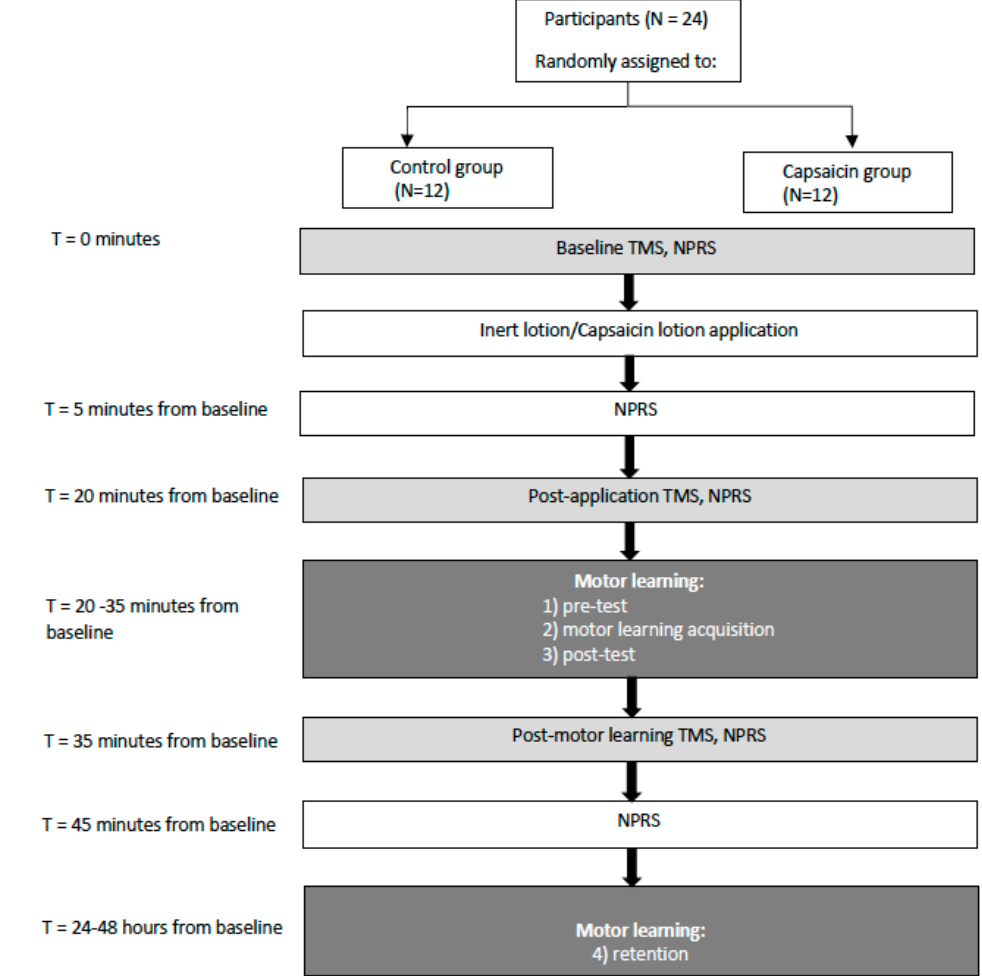
Figure 1. Schematic of the protocol illustrating that transcranial magnetic stimulation input–output (TMS IO) curves were performed at baseline, 20 min post-application, and then following the acquisition phase (45 min from baseline). Somatosensory evoked potentials (SEPs), numeric pain rating scale (NPRS).